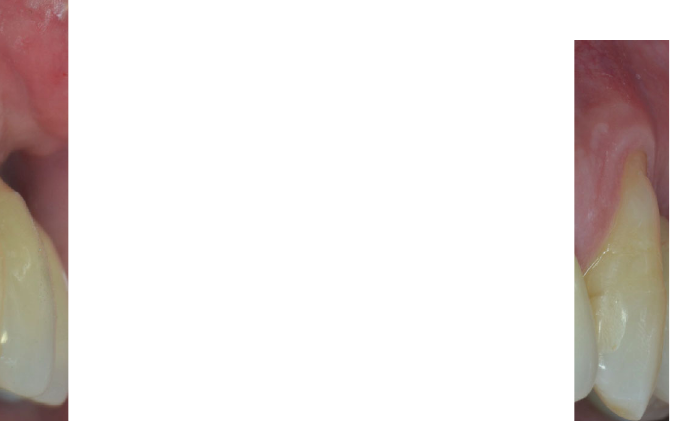
Figure 2: Lateral view: noncarious cervical lesion with composite restoration is evident (note the radicular concavity).